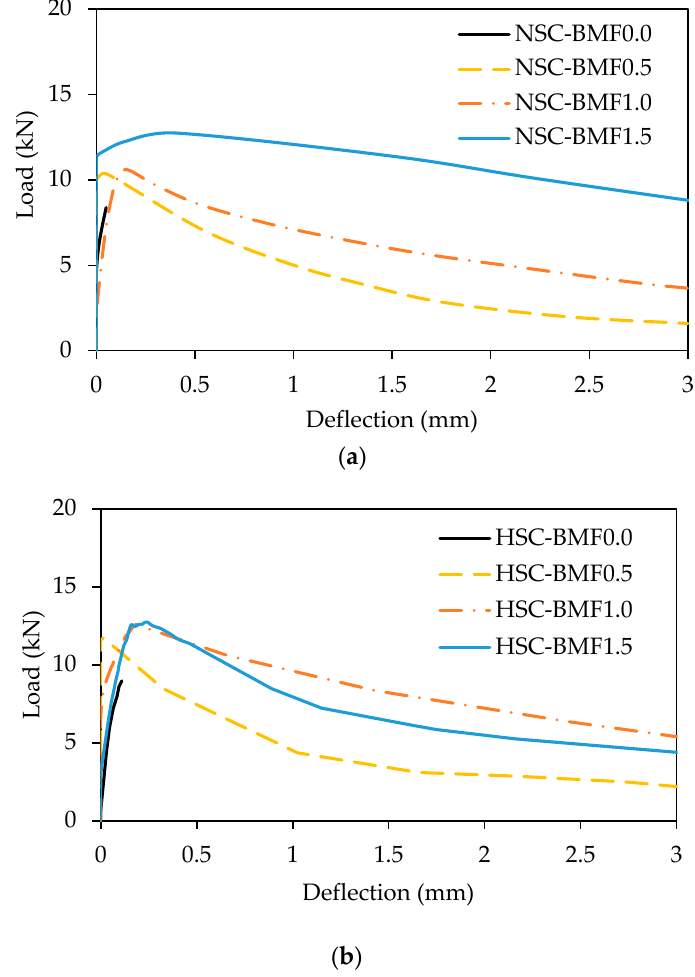
Figure 13. Load-deflection response: ( a ) NSC; ( b ) HSC.